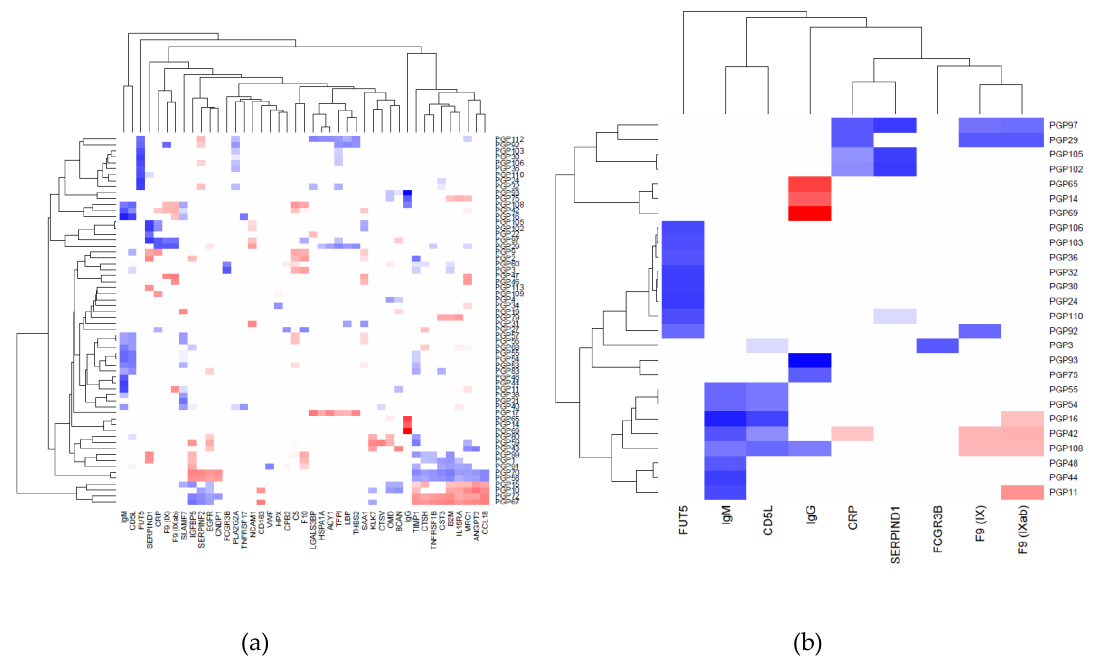
Figure 1. Replicated protein–glycan associations. ( a ) Correlation (r 2 ) between 62 glycan (rows) and 43 protein traits (columns); positive associations are in blue, negative in red; darker values indicate stronger associations; ( b ) limited to proteins and glycans that have at least one association with r 2 > 0.4. A fully annotated and filterable matrix for all associations is available in Excel format as Tables S4 and S5.